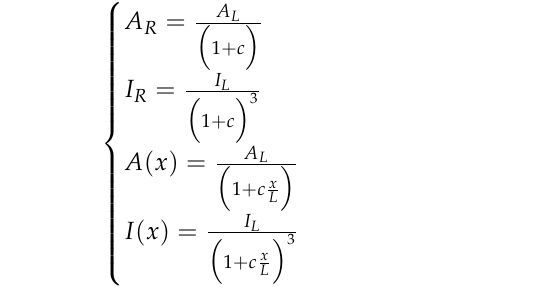
, T b are respectively the length, width, left-end L R